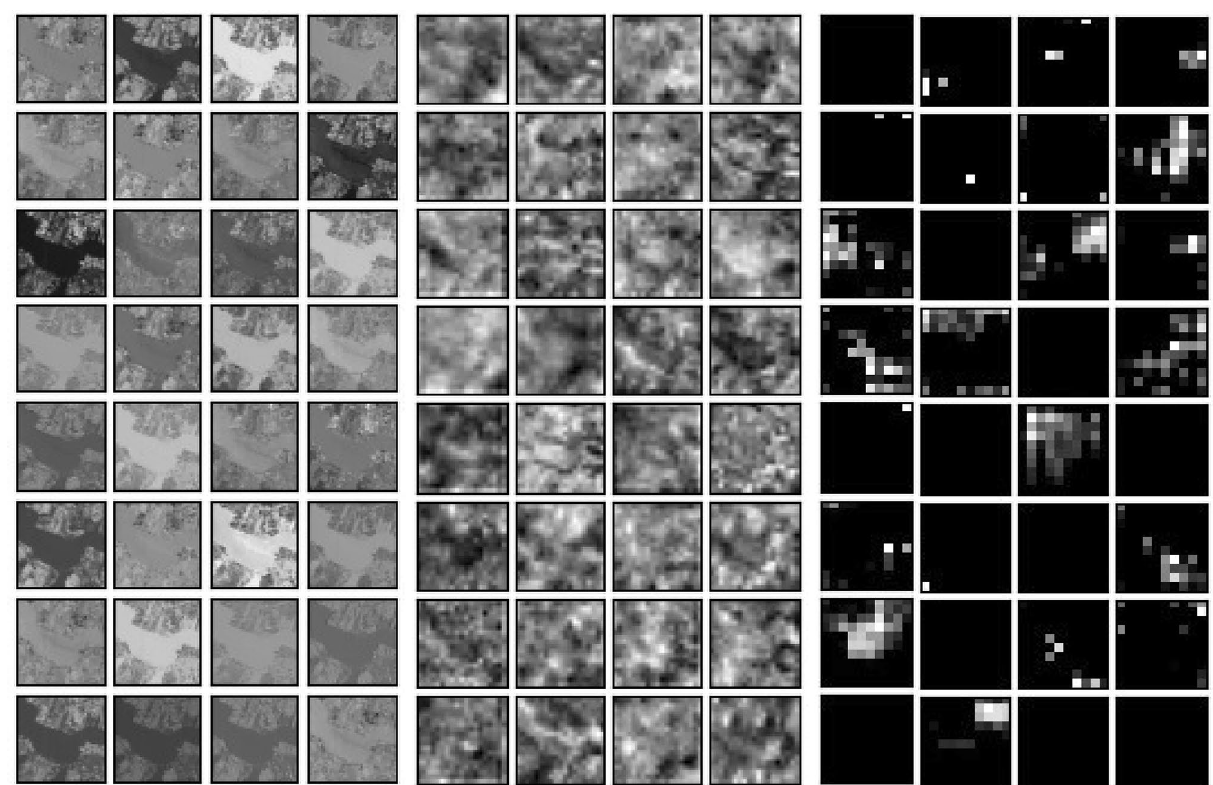
Figure 10. Represents the feature maps extracted from 1st hidden layer of Block1, Block7 and Block14. Feature Maps from all 14 Blocks are presented in